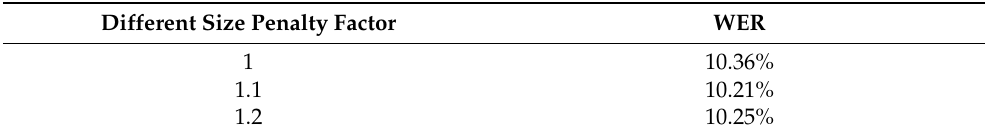
Table 6. Results for different sizes of penalty factor in the baseline Conformer model, where 1 represents no penalty factor used.